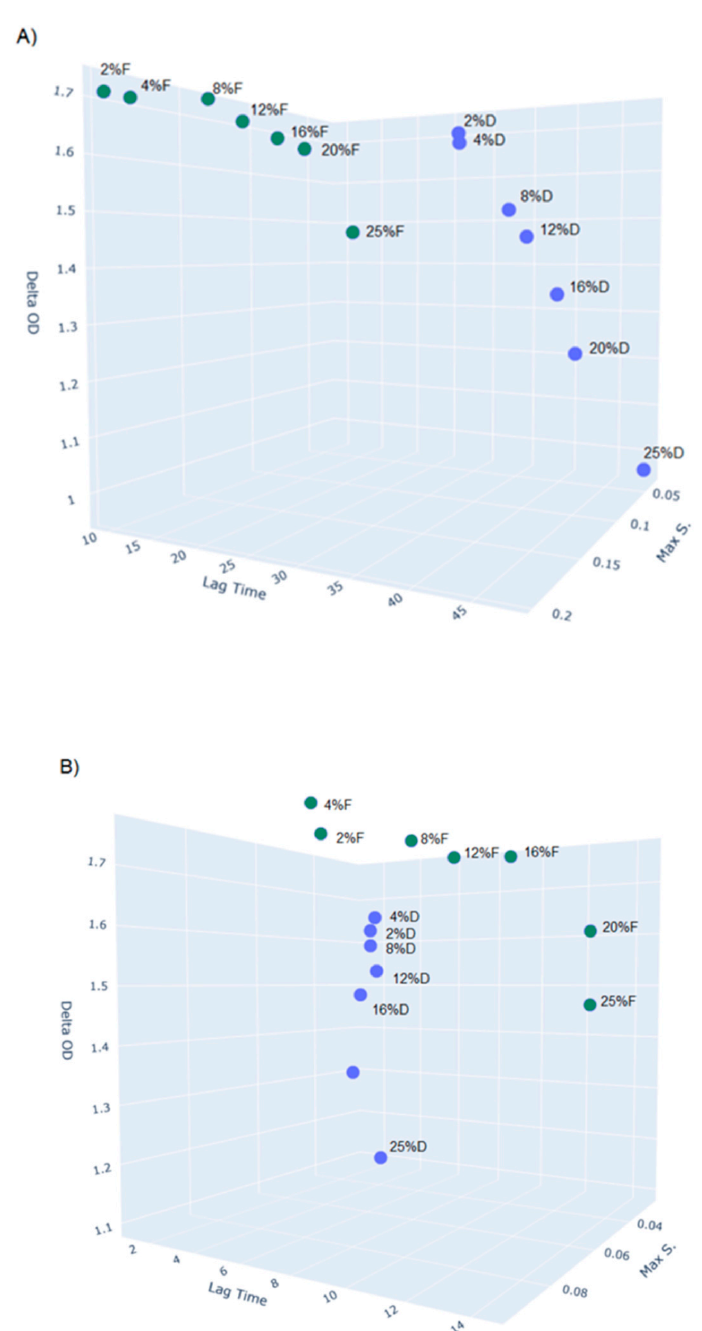
Figure 7. Growth kinetics of L. hilgrardii FLUB (green, F) and L. hilgardii DSMZ (blue, D) visualized as a three-dimensional scatter plot using plotly (Plotly Technologies INC., Montr é al , QC, Canada): ( A ) growth kinetics on MRS medium (without dextrose) enriched with fructose in the concentration range of 2–25%, ( B ) growth on MRS supplemented with glucose (2–25%). An interactive version and parameters calculated according to Hoeflinger et al. are available in the Supplementary Materials